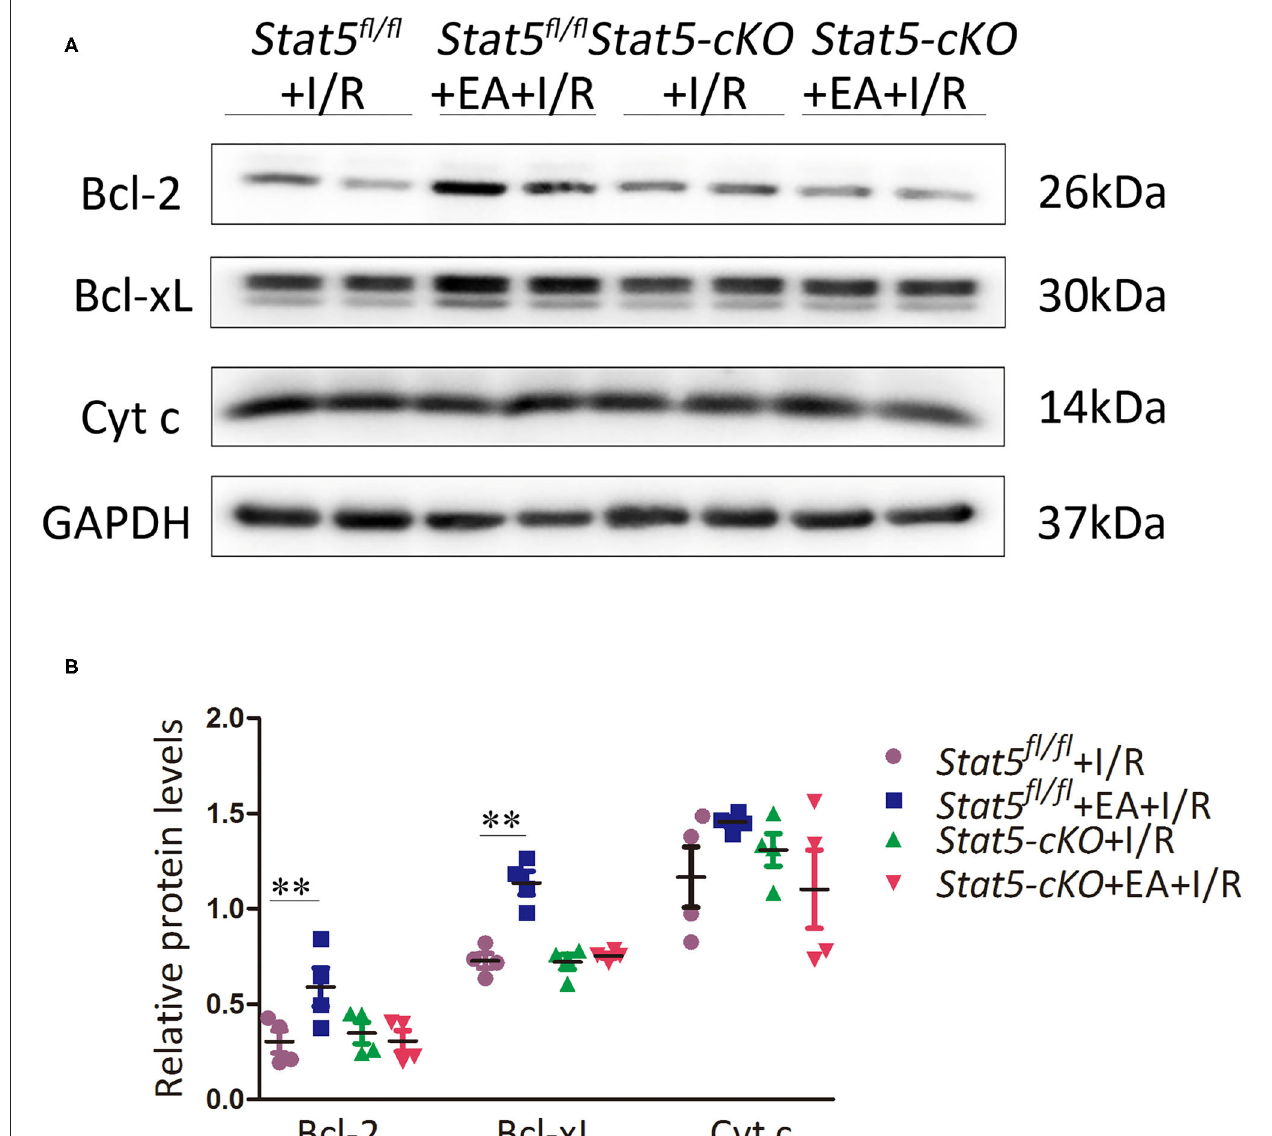
FIGURE 7 | The expression of apoptosis-related proteins. (A,B) Western blotting was used to detect the levels of Bcl-2, Bcl-xL, and Cyt c in each group. Data are presented as means ± SEM of more than three independent experiments. ** P < 0.01 compared with the Stat5 fl / fl + I/R group. Data were analyzed by two-way ANOVA with Bonferroni’s multiple comparison test, n =